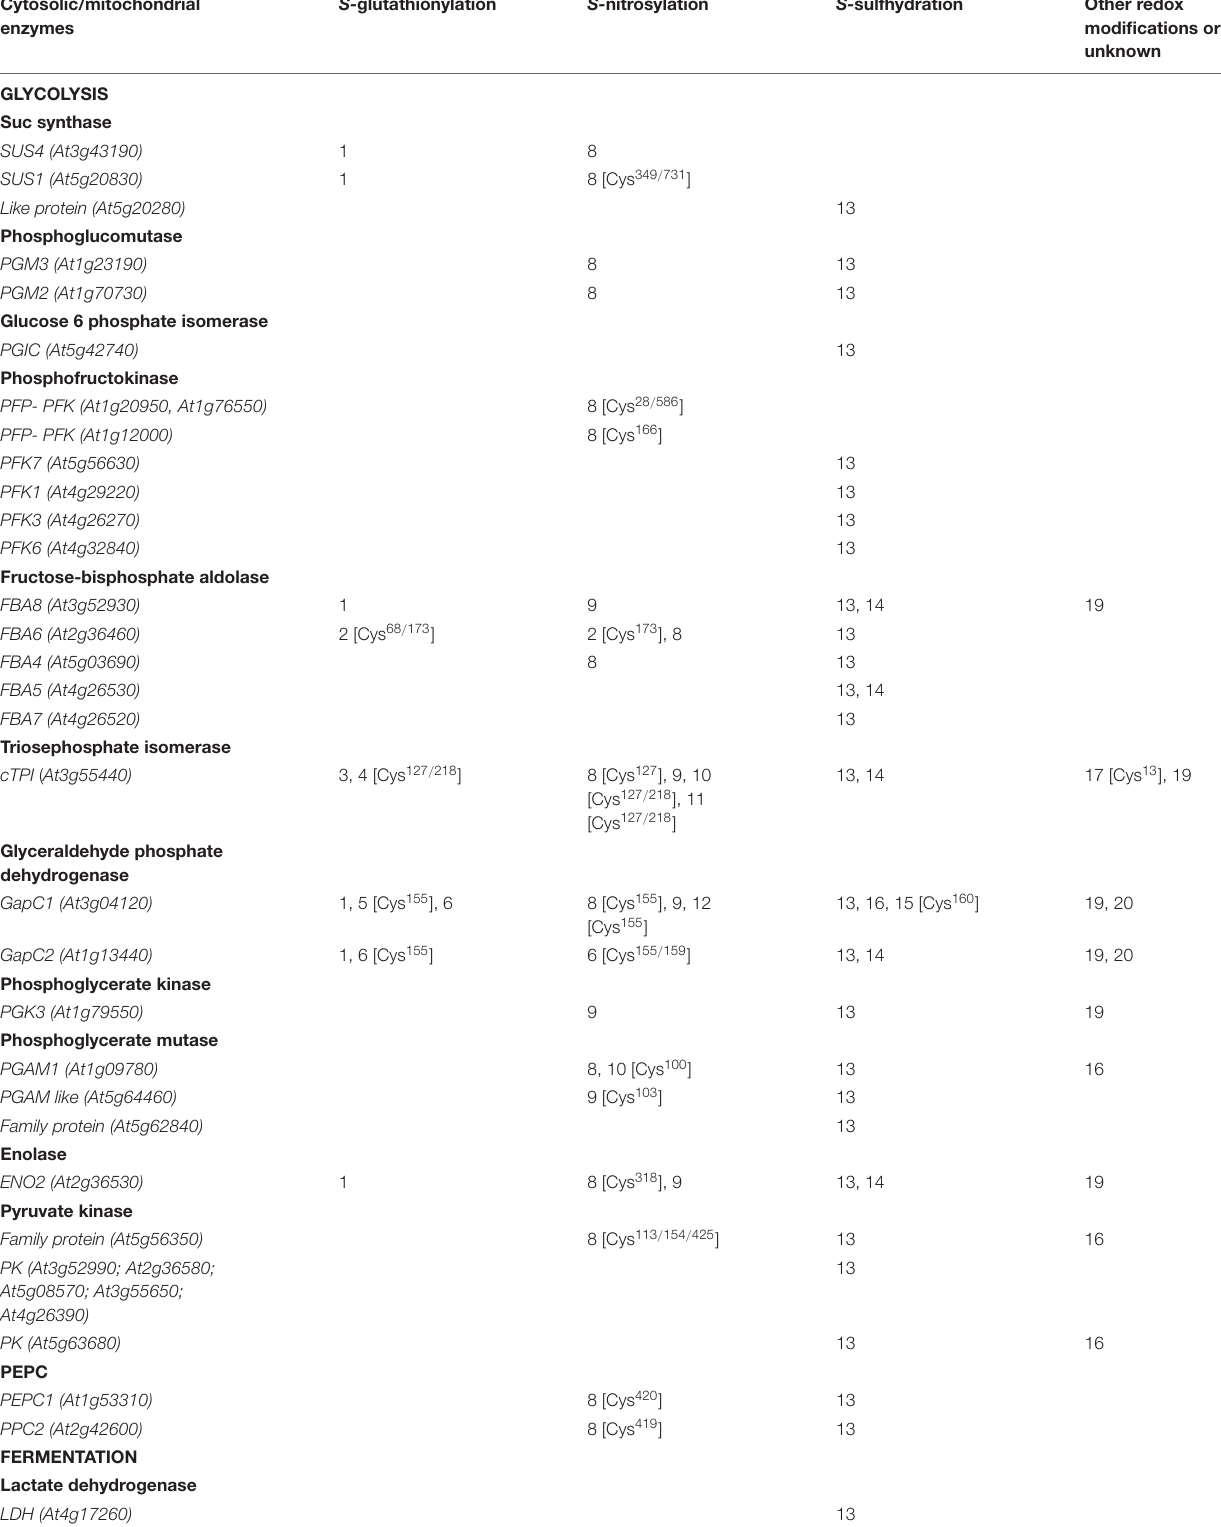
TABLE 1 | List of different redox modifications of A. thaliana proteins from glycolysis, fermentation, and TCA cycle identified from literature data. Cytosolic/mitochondrial S- glutathionylation S- nitrosylation S- sulfhydration Other redox enzymes